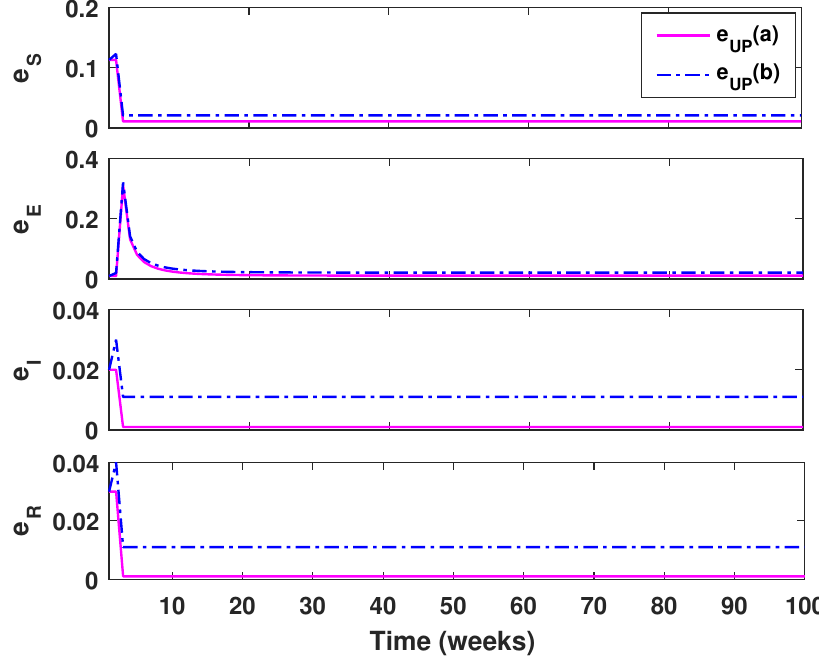
Figure 7. Upper-bound error: (a) proposed method; (b) method given in